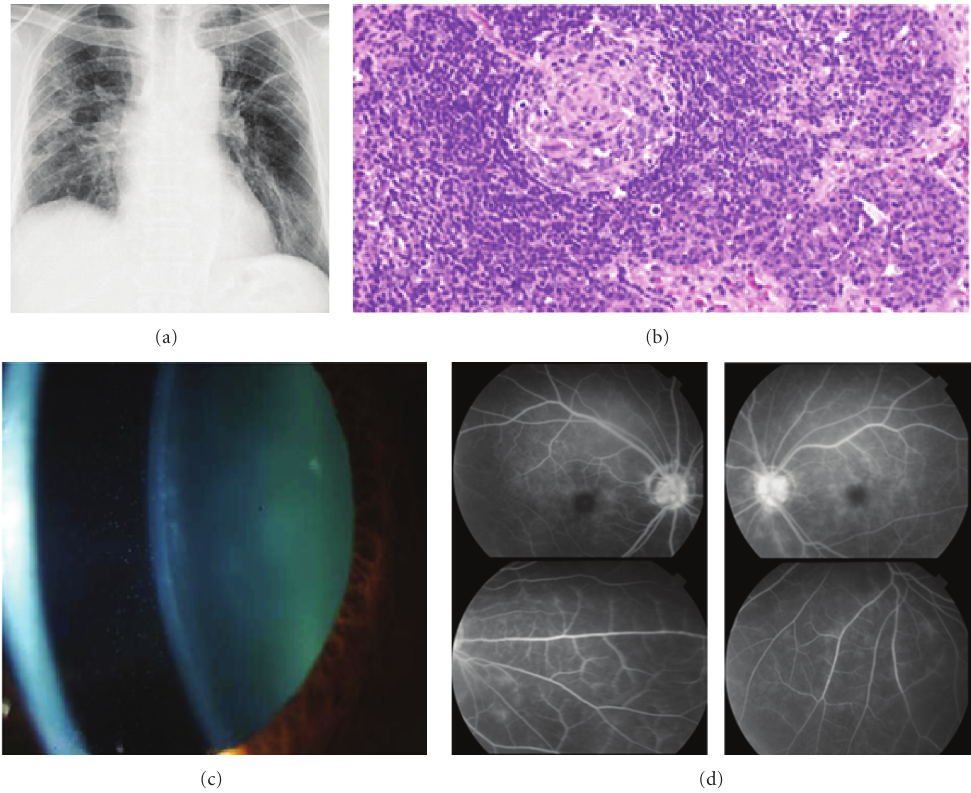
Figure 1: Clinical and pathological findings of a patient with Castleman disease before tocilizumab treatment. Panel (a) shows the thoracic X-ray photograph before tocilizumab treatment. Bilateral hilar lymphadenopathy and infiltrative shadows can be seen in both lungs. The infiltrative shadows remained unchanged for several years. Panel (b) shows the histopathological findings of the pulmonary lymph node performed in the Chiba Cancer Center ( × 200). Infiltrations of polyclonal plasma cells surrounding the mantle zones and a pattern of concentric deposits with lymphoid cells can be seen. Combined with the typical clinical findings, the patient was diagnosed with Castleman disease. Panel (c) shows a slit-lamp photograph of the anterior chamber before tocilizumab treatment. Large cells (3+) without flare can be seen in the anterior chamber. Panel (d) shows FA findings detecting increased vascular permeability from the retinal vessels and hyper fluorescence of the optic discs in both eyes before